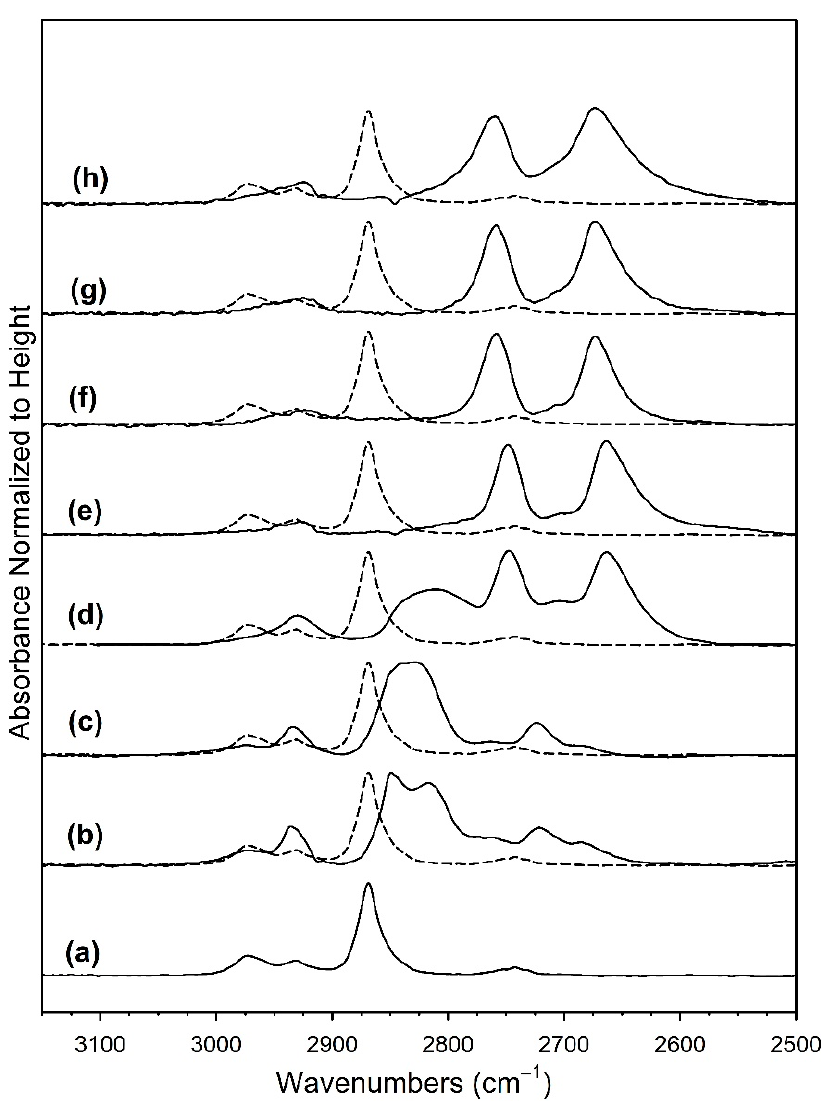
Figure 13. Absorbance of the formate ν (CH) band region normalized to height of band on 2% Pt/ZrO 2 , including ( a ) 2% Pt/ZrO 2 , ( b ) 2.9% Cs-2% PtZrO 2 , ( c ) 3.9% Cs-2% Pt/ZrO 2 , ( d ) 4.8% Cs-2% Pt/ZrO 2 , ( e ) 5.8% Cs-2% Pt/ZrO 2 , ( f ) 7.2% Cs-2% Pt/ZrO 2 , ( g ) 10.4% Cs-2% Pt/ZrO 2 , and ( h ) 14.5% Cs-2% Pt/ZrO 2 (reprinted from [20] with permission from Catalysts, MDPI).